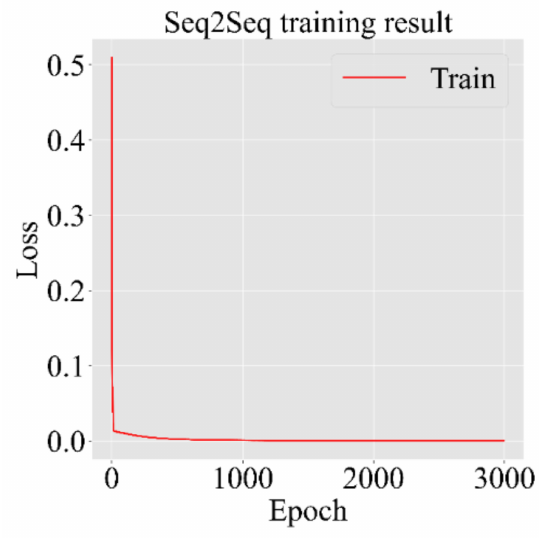
Figure 9. Graph for Seq2Seq model training